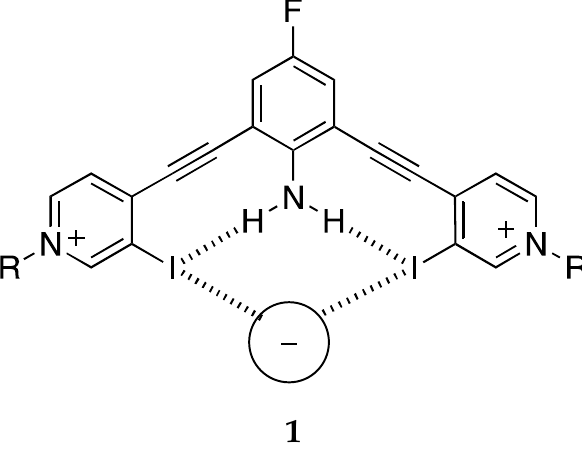
Scheme 1. Schematic description of 2,6-bis(4-ethynylpyridinyl)-4-fluoroaniline interacting with